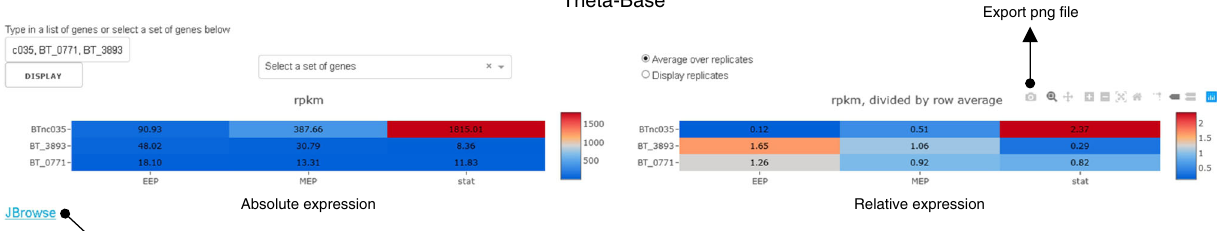
two or more genera within the Bacteroidetes phylum, while the remaining 27 are strain-speci fi c (Supplementary Fig. 3a). Analysis